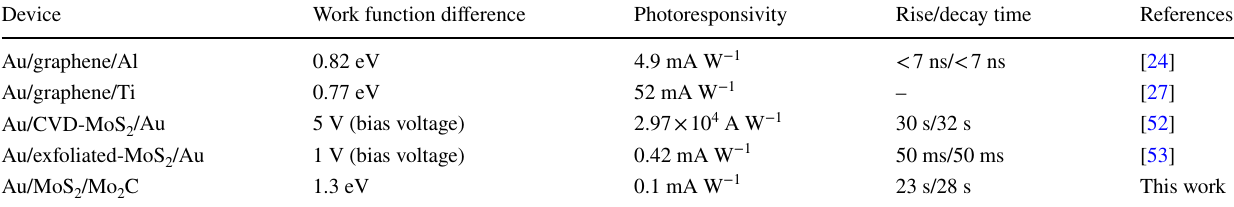
Table 1 Comparison of the characteristics and performance of Mo 2 C/MoS 2 /Au photodetectors with photodetectors with other structures